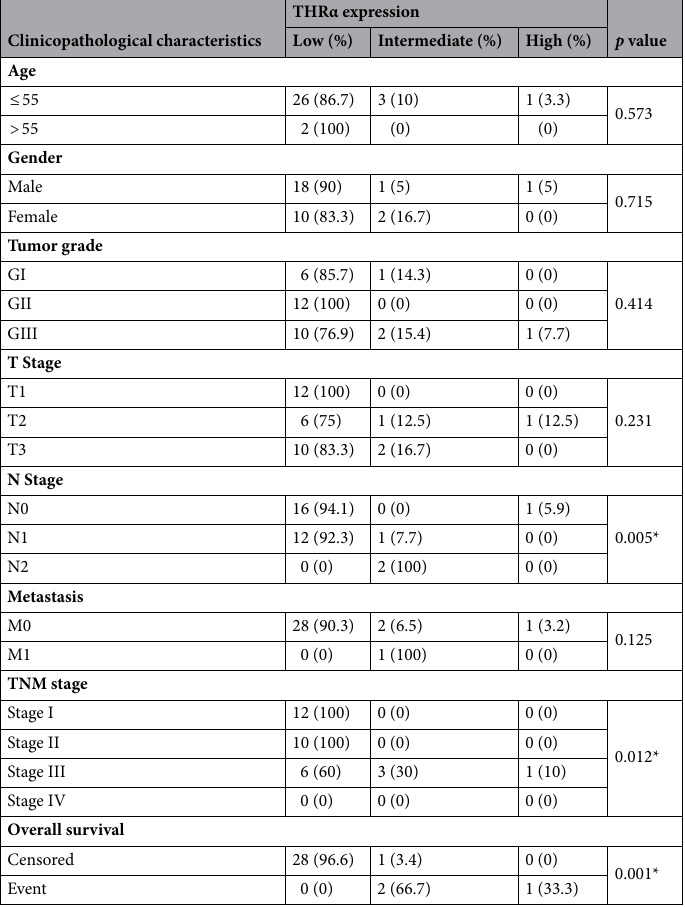
Table 3. The association between THRα1 expression and clinicopathological characteristics of NSCLC (AC) cases (No = 32). Test of significance: Chi-square and Fisher exact tests. p -value < 0.05 is considered